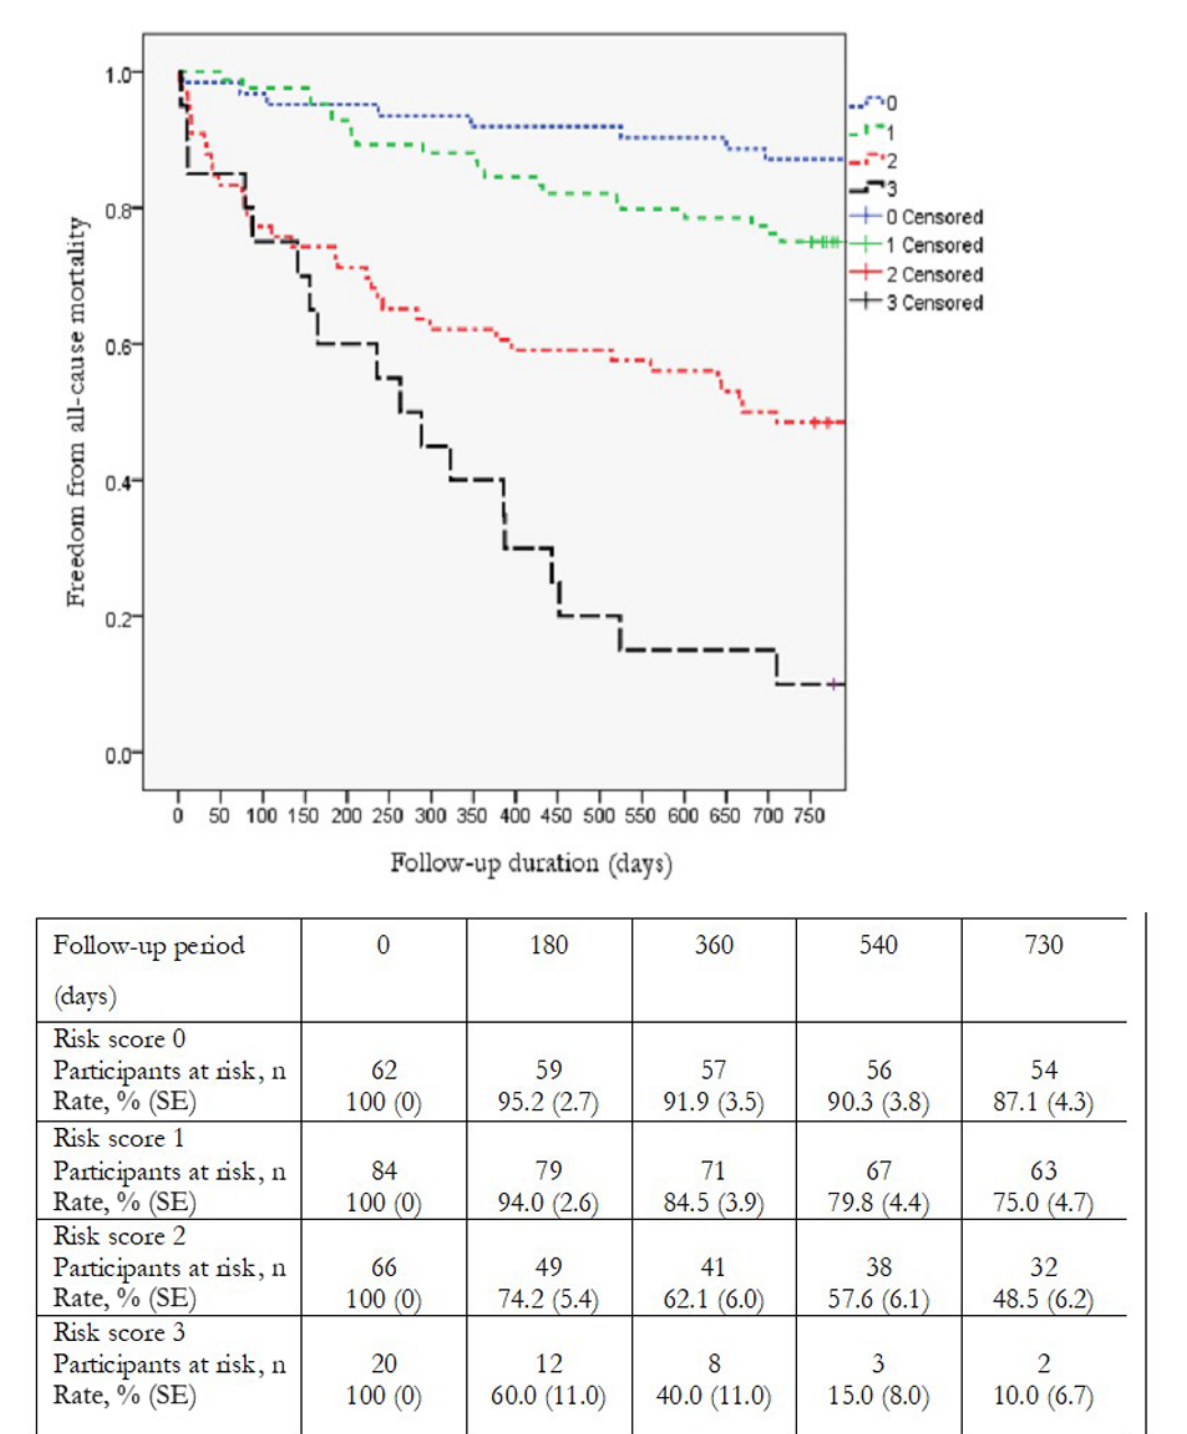
Figure 6. Kaplan-Meier analysis of 2-year survival in model